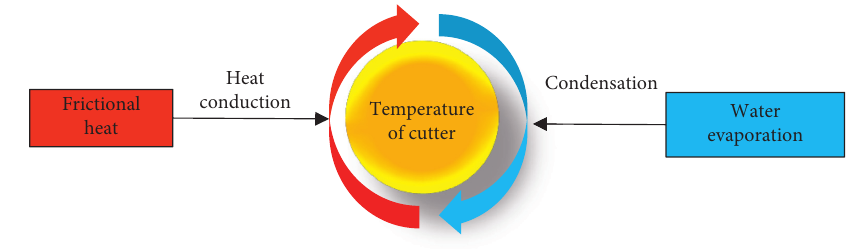
Figure 9: Schematic diagram of the change in disc cutter temperature.